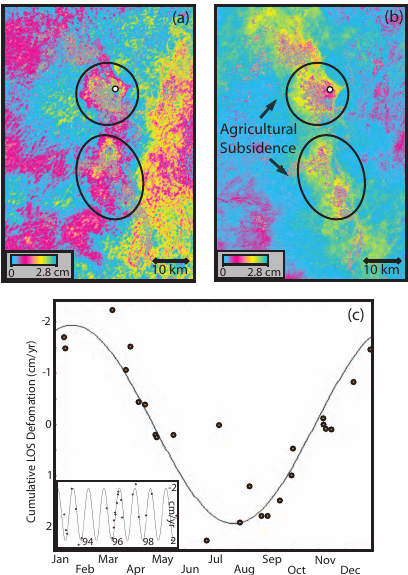
Figure 3. ( a , b ) Wrapped interferograms of ( a ) uplift from 15 August 1992 to 2 January 1993 and ( b ) subsidence from 31 December 1996 to 20 May 1997 near Roswell, NM, with location (white dot, approximate location: 33.2 ◦ N, − 104.3 ◦ W) of the time series shown in ( c ). ( c ) Line-of-sight (LOS) displacements vs. day of year and vs. absolute date